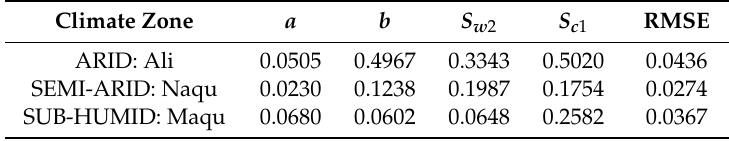
Table 3. Summary of the results of the calibration with the SMAR